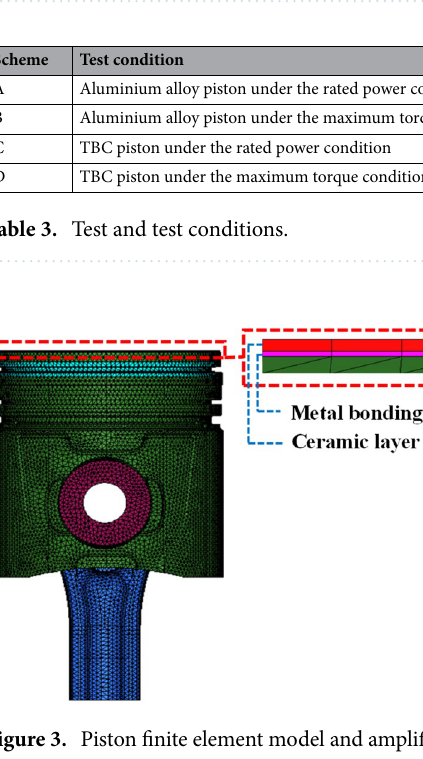
Figure 2. Lead physical diagram of thermocouple wire.